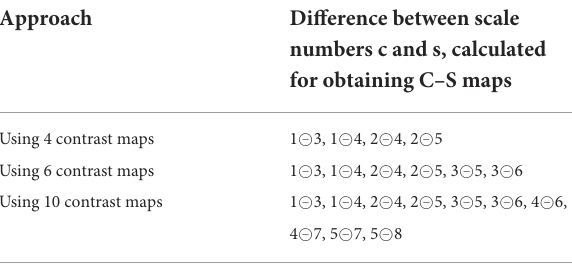
TABLE 1 A detailed description of the calculations in equations 2–6 for obtaining C–S difference maps for each feature. Approach Difference between